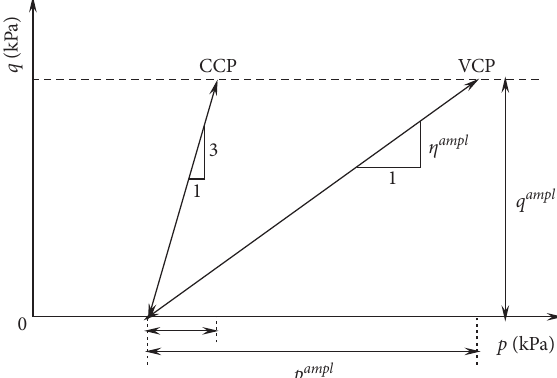
Figure 3: Stress paths of the tests in p-q